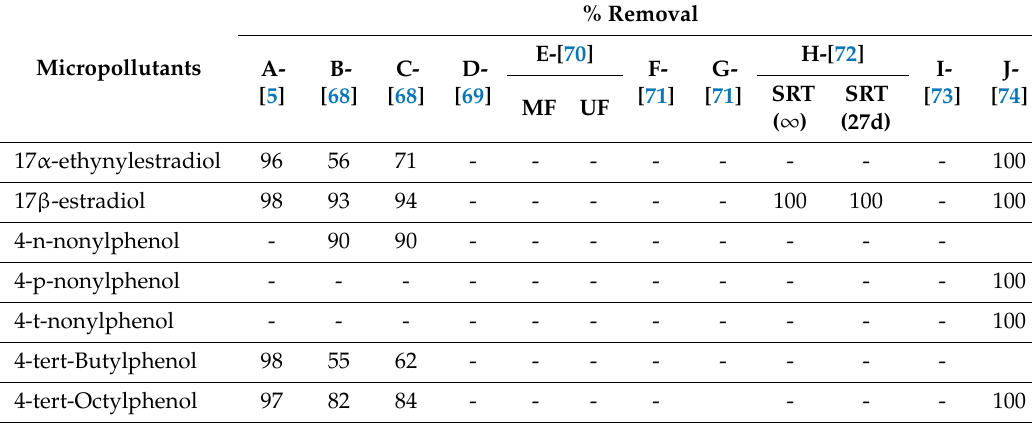
Table 1. Organic micropollutants (OMPs) removal for aerobic membrane bioreactors (MBRs).